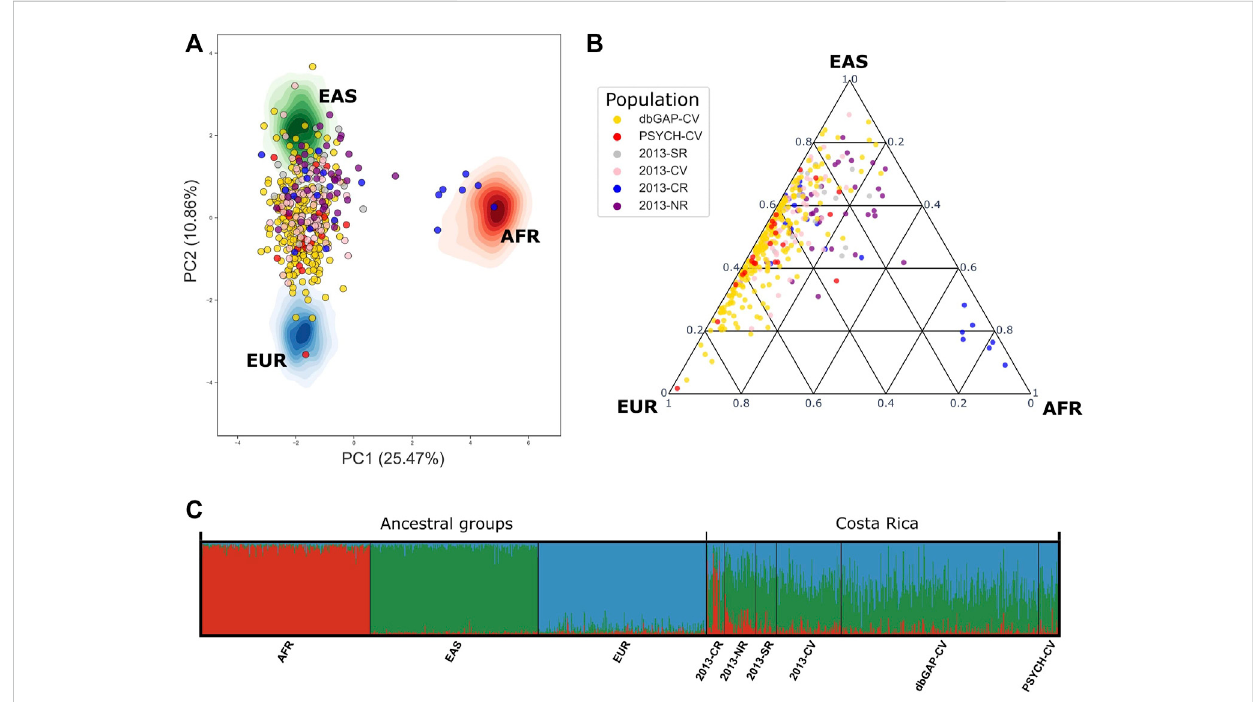
FIGURE 4 Genetic admixture in PSYCH-CV and dbGAP-CV using 78 AIMs reported by Campos-Sánchez et al. (2013). (A) Principal component analysis, (B) Genetic admixture ternary diagram. (C) Individual genetic structure plot. AFR: Africa, EAS: East Asia, EUR: Europe, AMR: Latin America, 2013-CR: Costa Ricans from the Caribbean Region, 2013-NR: Costa Ricans from the North Zone, 2013-SR: Costa Ricans from the South Zone, 2013-CV: Costa Ricans from the Central Valley, PSYCH-CV: Psychiatric study Central Valley, dbGAP-CV: dbGAP Central Valley.